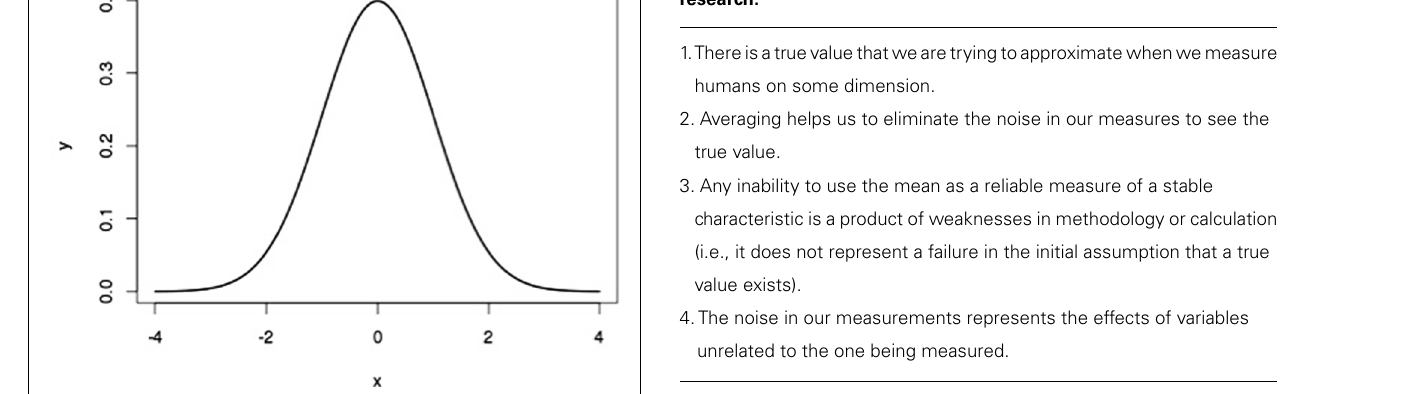
Table 1 |Assumptions underlying the use of the mean in psychology